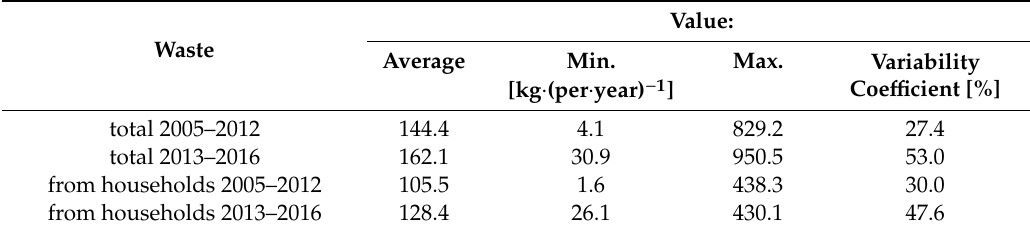
Table 3. Description of the unit indicator of waste accumulation.